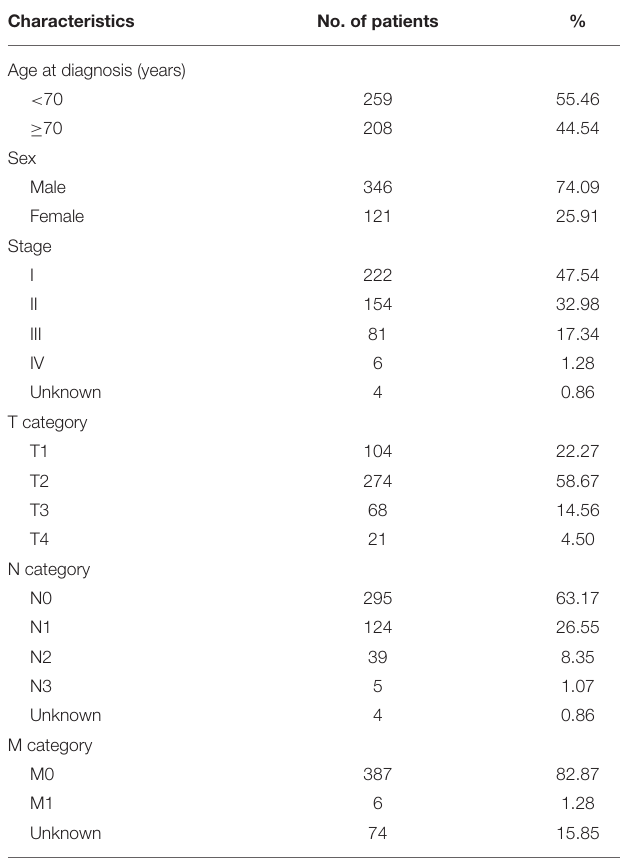
TABLE 1 | Characteristics of patients with LUSC from TCGA